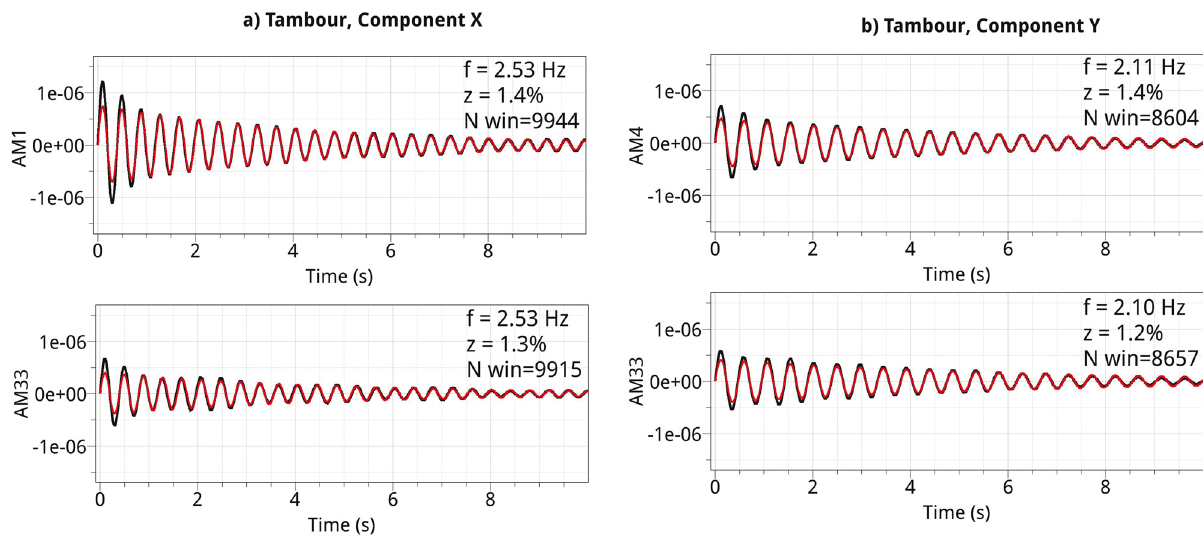
Figure 5. RDM analysis for the accelerometers located on the tambour. The X and Y components are plotted in the panel (a) and (b), re- spectively. The time-length of recordings is 1 hour (within the day 25 January of 2012). The computed decay curve and the fitting exponen- tially function are indicated as black and red line, respectively. The resonance frequency (f), the damping ratio (z in %) and the number of selected time-windows from RDM analysis are also indicated in the corner of each plot. Units in the y-axis are